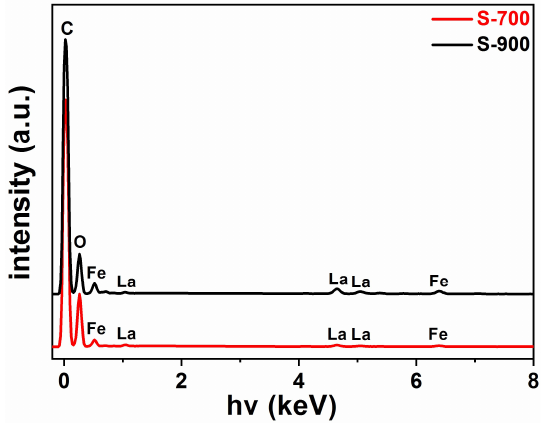
Figure 3. Energy dispersive X-ray (EDX) spectra of LaFeO 3 at different calcination temperatures (S-700, S-900).